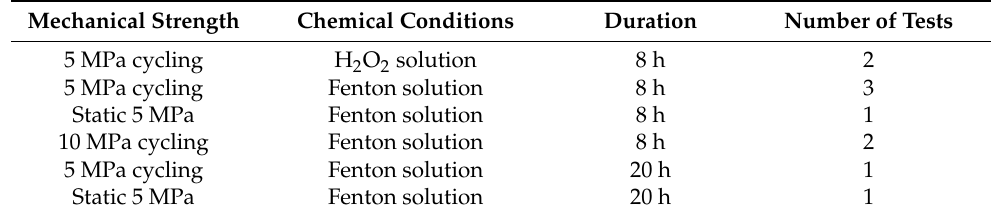
Table 1. Summary of the operating conditions used for the ex situ mechanical-chemical aging tests. Mechanical Strength Chemical